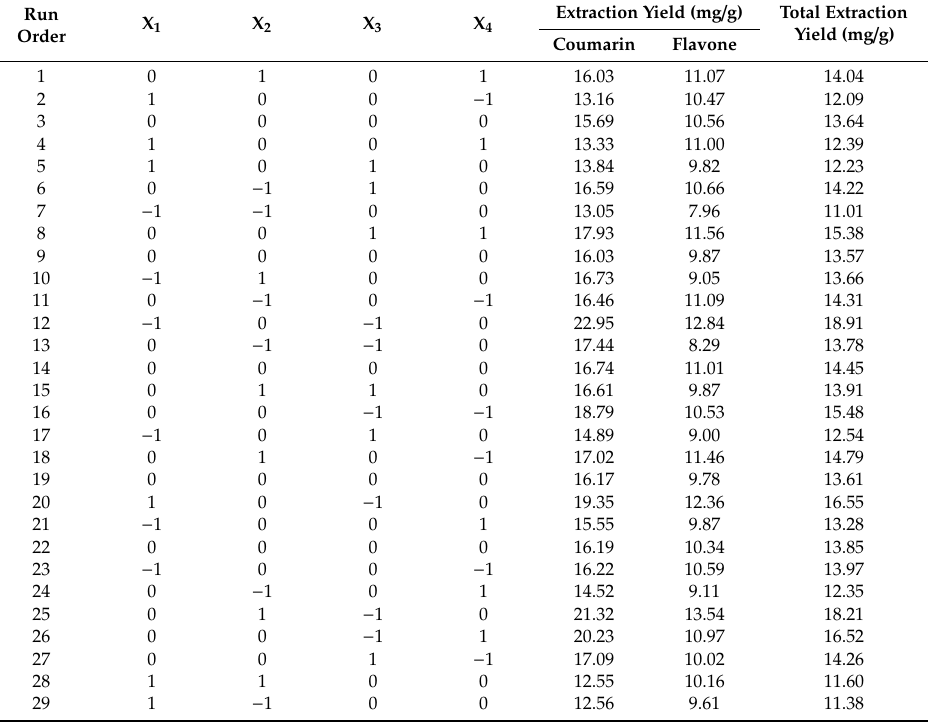
Table 4. Experimental design and results of